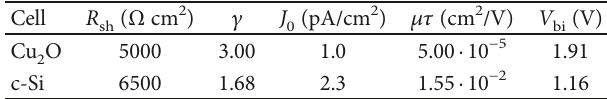
Table 1: Single-diode model parameter values of the Cu ideal cells.